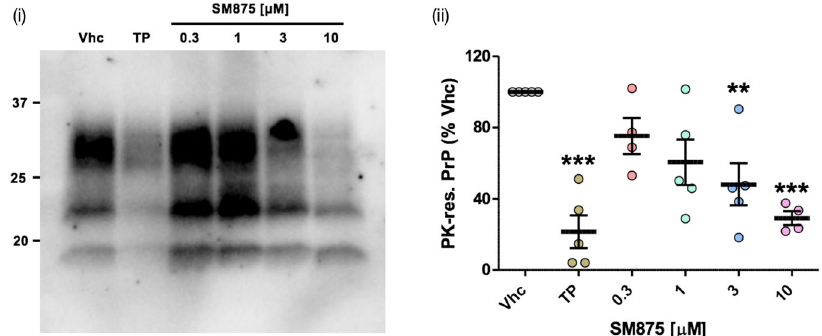
Fig. 6 SM875 inhibits prion replication in L929 mouse fi broblasts. L929 mouse fi broblasts were infected with the RML prion strain and then propagated for fi ve sequential passages before exposure to SM875 (indicated concentrations), anti-prion compound Fe 3 + -TMPyP (TP, 10 μ M) or vehicle (0.1% DMSO) for 48 h. PrP Sc loads were then estimated by treating cell lysates with PK and analyzing PrP content by western blotting (i). Signals were detected by probing membrane blots with anti-PrP antibody (D18). Results show that SM875 inhibits prion replication in a dose-dependent fashion, with the maximal effect (obtained at 10 μ M) comparable to that of TP; (ii) the graph shows the densitometric quanti fi cation of all PK-resistant PrP bands from independent replicates (n ≥ 4). Quanti fi cation was obtained by densitometric analysis of the western blots, normalizing each signal on the corresponding PK-untreated lane and expressed as the percentage of vehicle (Vhc)-treated controls (** p < 0.01, *** p < 0.005, by one-way ANOVA